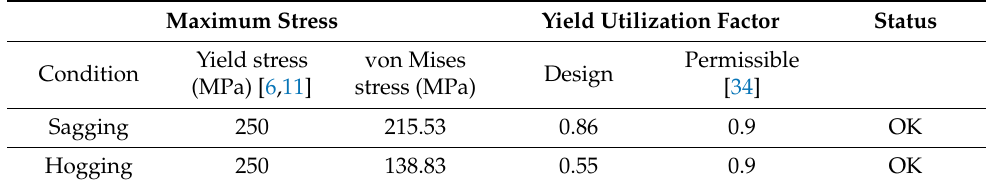
Table 7. Parameters of stiffened panel with angle-bar stiffener at deck and bottom and related properties of